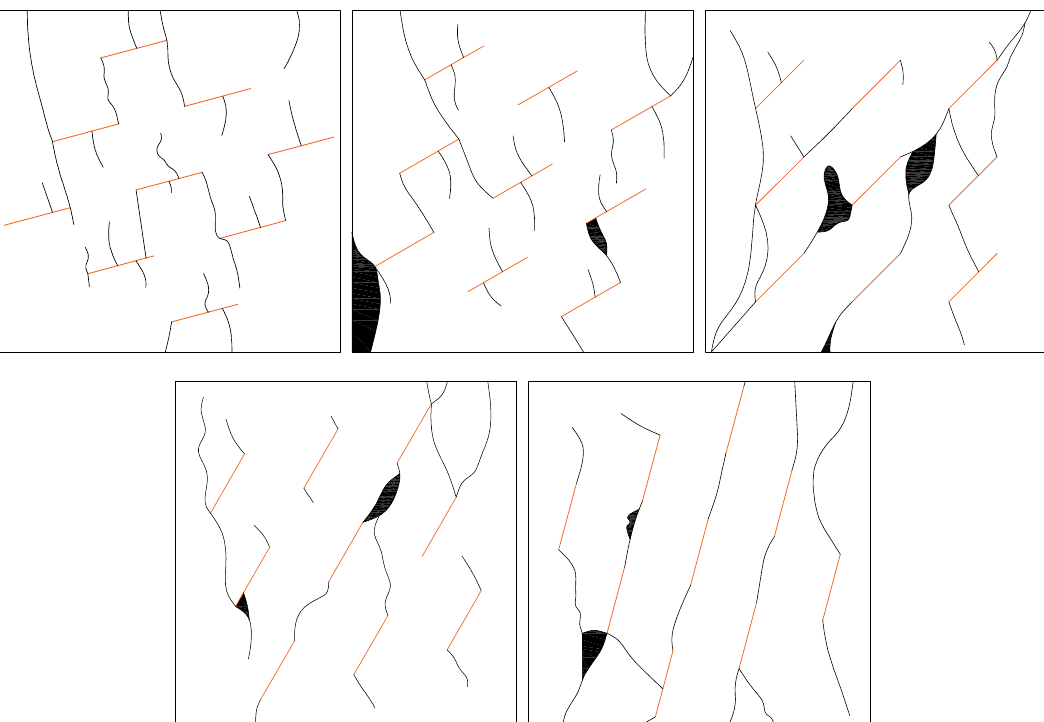
Figure 19. Rock-like materials with nine parallel fissures: the experimentally obtained crack paths (the shadows indicate broken